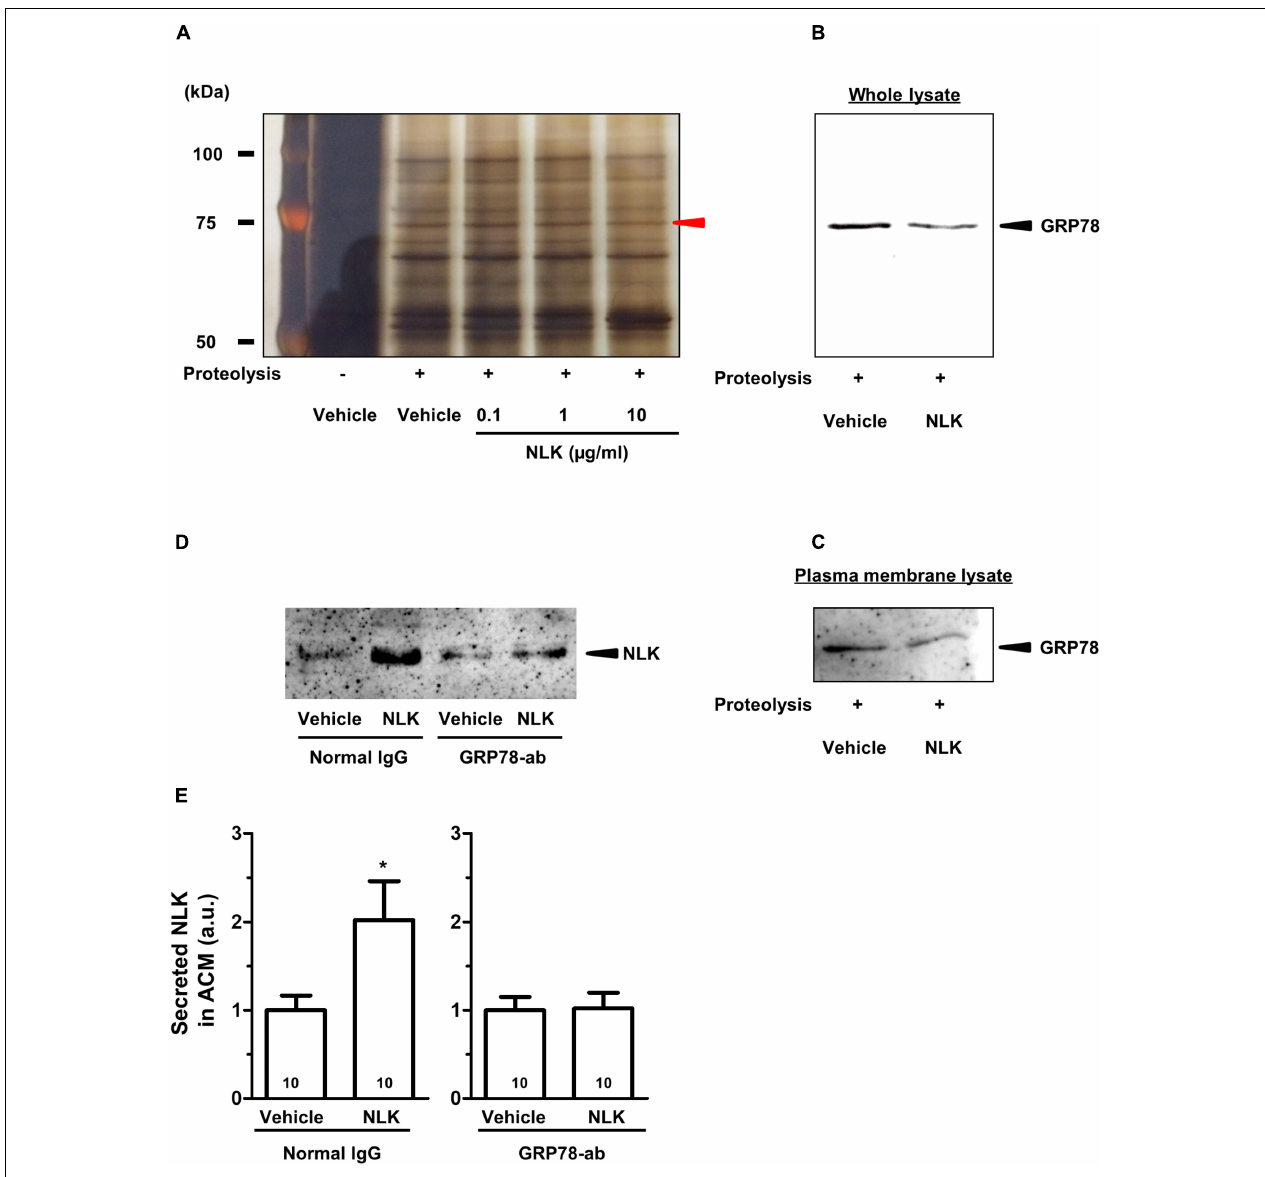
FIGURE 4 | NLK bound to 78 kDa glucose-regulated protein (GRP78) in cultured astrocytes. (A) Following the drug affinity responsive target stability (DARTS) reaction, samples were electrophoresed and silver stained. The red arrowhead indicates a candidate band whose band thickness is different between the vehicle-treated lysates and NLK-treated lysates. The band was analysed using a Nano LC-MS/MS mass spectrophotometer and was identified as GRP78. (B) GRP78 after thermolysin digestion of cell lysates treated with vehicle or neuroleukin (NLK) and analysed by western blotting. (C) GRP78 after thermolysin digestion of membrane-associated lysates following treatment with vehicle or NLK and analysed by western blotting. (D) Spinal cord astrocytes were cultured for 4 days and then treated with a GRP78 neutralising antibody (2 µ g/ml) or normal IgG (2 µ g/ml) for 15 min. Thereafter, NLK (500 ng/ml) was administered to the cells. At 5 days post NLK-treatment in vitro , the medium was replaced with serum-free medium and the cells were cultured for 24 h to generate astrocyte conditioned medium (ACM). NLK in ACM was detected by western blotting. (E) The band intensity of NLK in ACM was quantified. ∗ p < 0.05 vs. vehicle, unpaired two-tailed t -test. Numbers in the graph bars indicate the number of experiments independently